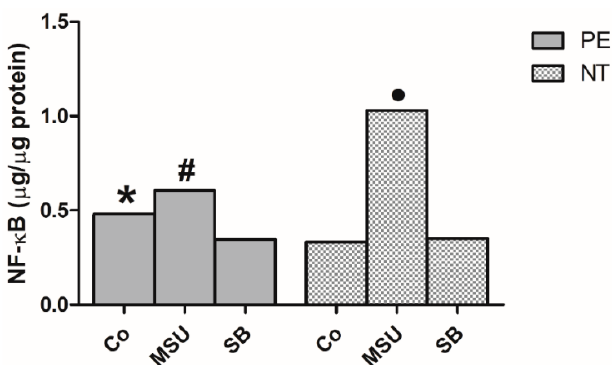
Figure 2. NF- κ B concentration in nuclear extracts of monocytes from 20 pregnant women with preeclampsia (PE) and 20 NT pregnant women, cultured in the absence (Co) or presence of MSU or SB. Results are expressed as the median. * p < 0.05 vs. NT Co, PE SB; # p < 0.05 vs. PE Co, PE SB; • p < 0.05 vs. NT Co, NT SB (Kruskal-Wallis test).